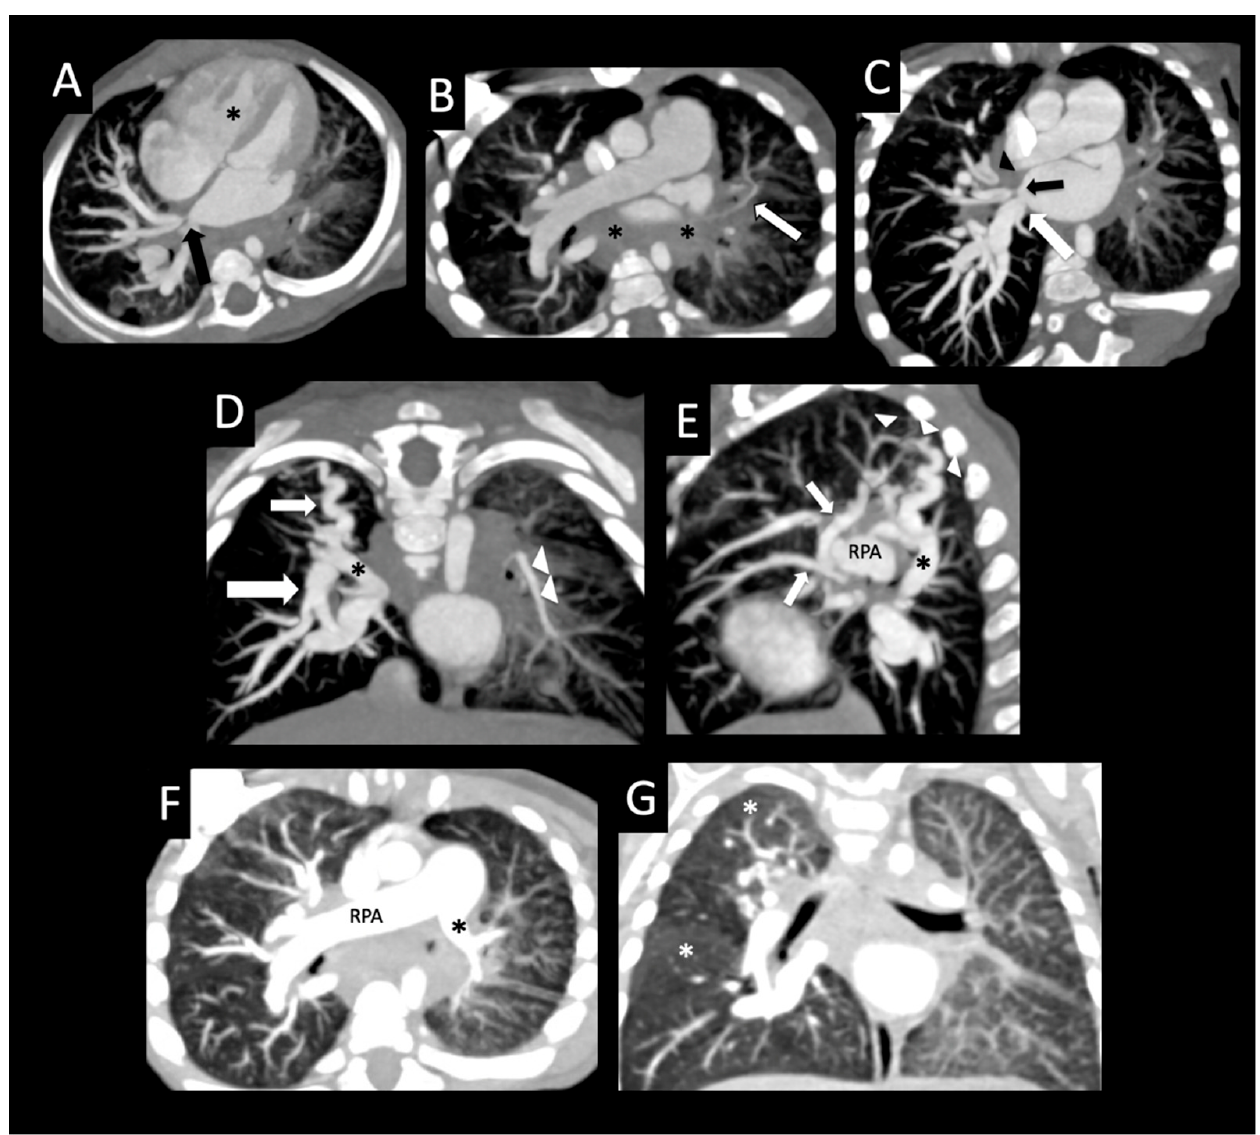
Figure 7. Bilateral pulmonary vein stenosis with collaterals. Congenital dyserythropoiesis with anemia, presenting at 5 months of age with bilateral pulmonary vein stenosis, followed by surgical left common and right upper pulmonary vein repair. CT performed 6 months after surgery shows right ventricular hypertrophy (axial image ( A )) with septal flattening (*) consistent with pulmonary hypertension. There is severe right middle pulmonary vein ostial stenosis (arrow), and diffusely hypoplastic left lower and left upper pulmonary veins (arrow axial image ( B )) with bilateral left > right perihilar induration (*). Axial oblique image ( C ) shows ostial right upper pulmonary vein atresia (arrowhead), right middle pulmonary vein severe stenosis (small arrow), and right lower pulmonary vein mild stenosis (large arrow). A large tortuous venous collateral from the right upper lobe (small arrow, ( D )) connects to the superior segment right lower pulmonary vein (*). The distal right pulmonary artery is large (large arrow) relative to diffusely small distal left pulmonary artery (arrowheads). Sagittal oblique image ( E ) shows peripheral branches of the atretic right upper pulmonary vein (small arrows) with central atresia related to the dilated right pulmonary artery. A collateral network (arrowheads) connects branches of the right upper pulmonary vein to the superior segment right lower pulmonary vein (*), which is unobstructed to the left atrium. Small left lung and left pulmonary artery (*) relative to the right (axial ( F )). Diffuse interlobular septal thickening and ground glass opacity (consistent with edema) throughout the left lung (coronal image ( G )), and more mild ground glass opacity involving the right upper and middle lobes (*).